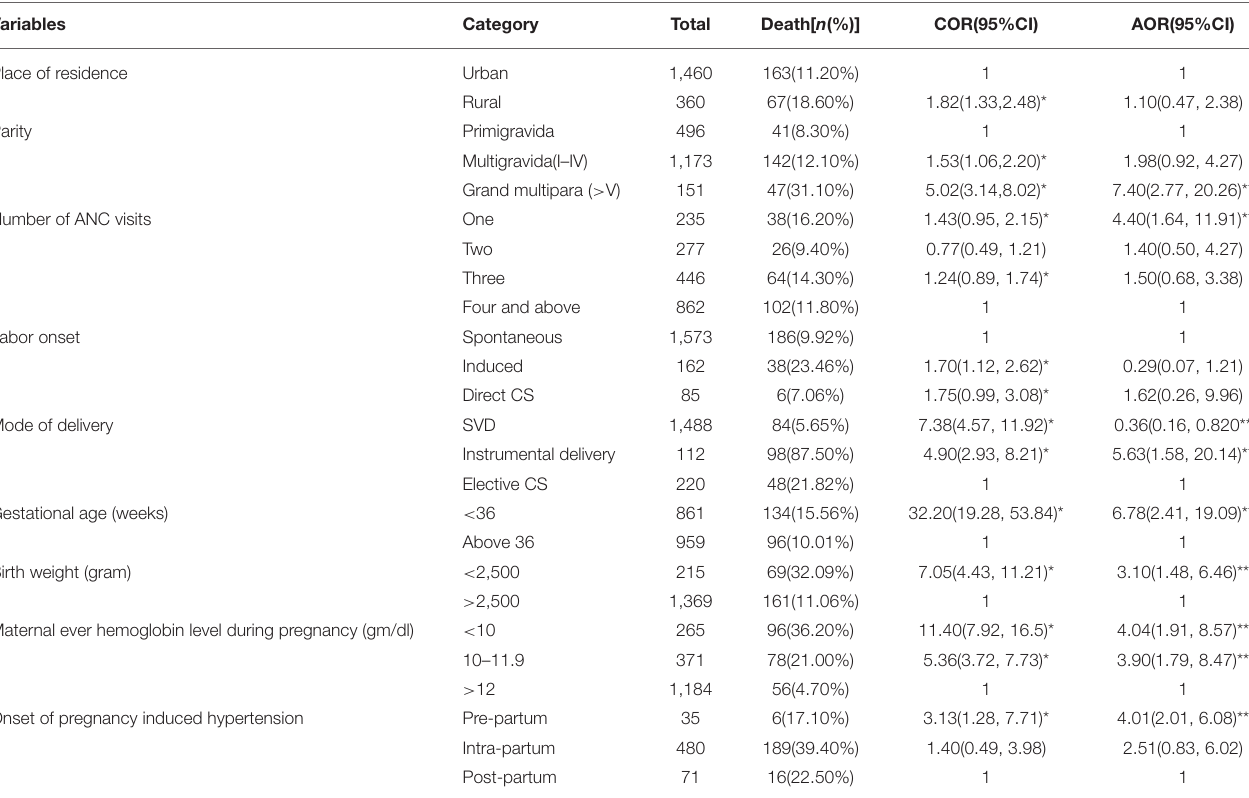
TABLE 3 | Factors associated with perinatal mortality among mothers who attended ANC in Gamo Zone public Hospitals, Southern Ethiopia, 2019.